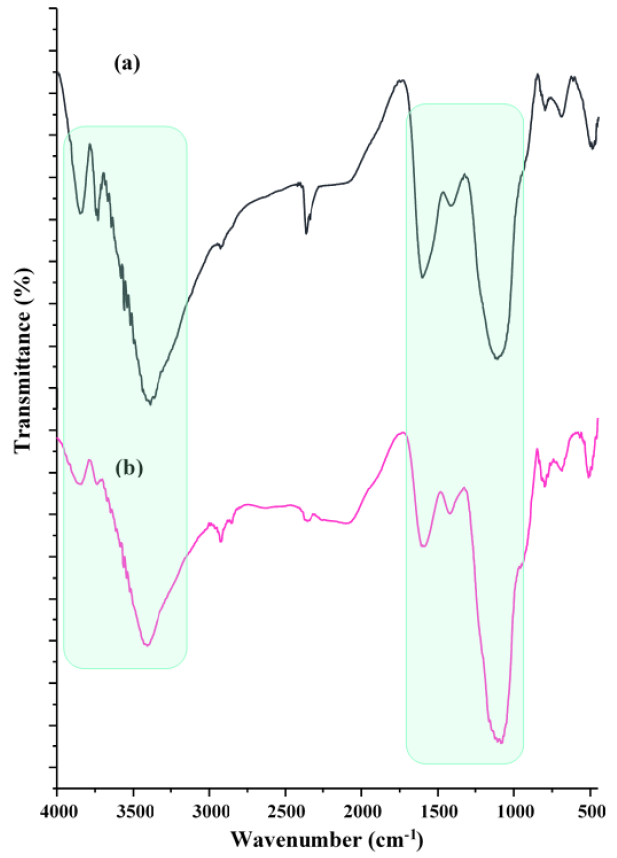
Figure 2. FTIR spectra of ( a ) MCAC and ( b ) MCAC after MV 2B adsorption.